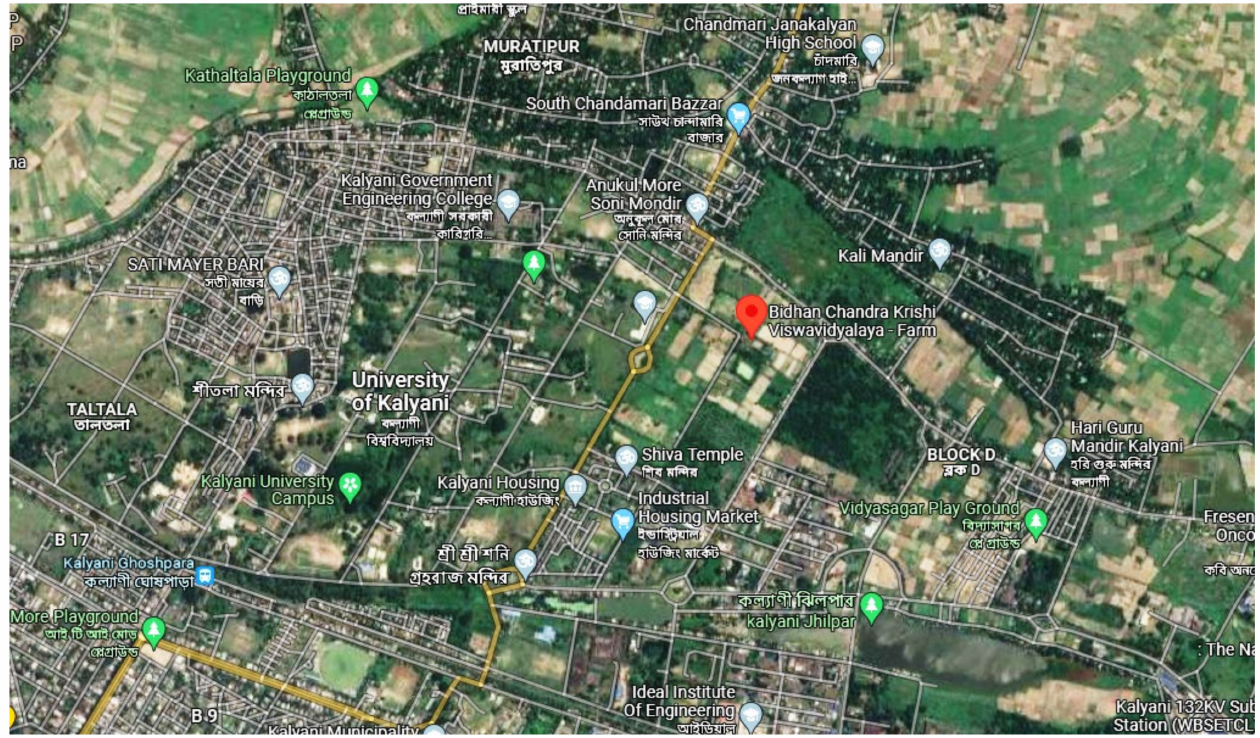
Figure 1. Map of the research farm where the study was